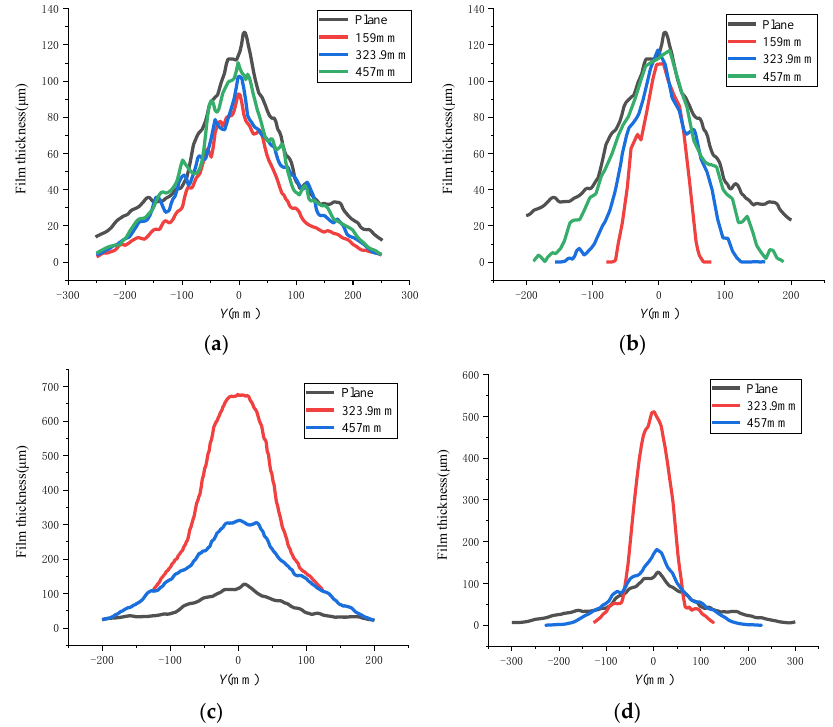
Figure 17. Film thickness distributions of the dynamic spraying. ( a ) Rotary spraying on the outer surface. ( b ) Outer surface translation spraying. ( c ) Rotary spraying on the inner surface. ( d ) Translation spraying on the inner surface.